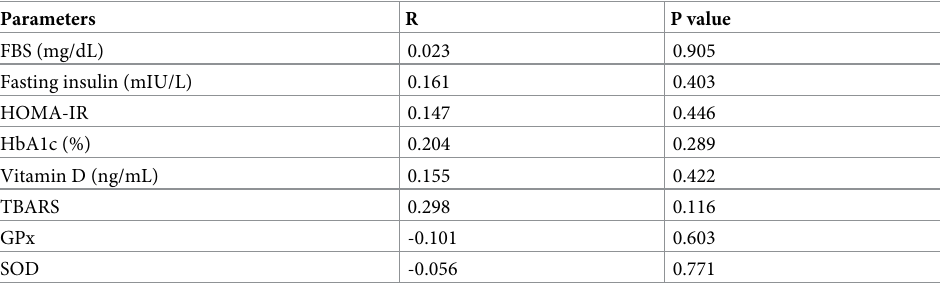
Table 9. Correlation between 3MS score and various biochemical parameters among non-diabetic subjects with vitamin D